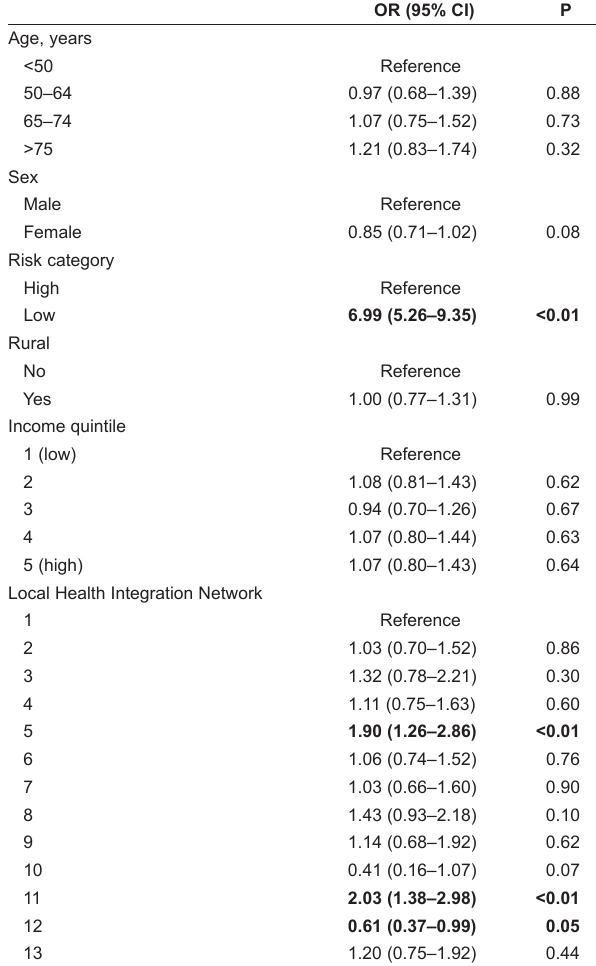
TAble 2 Multivariable logistic regression analysis for patients receiving neither abdominopelvic computed